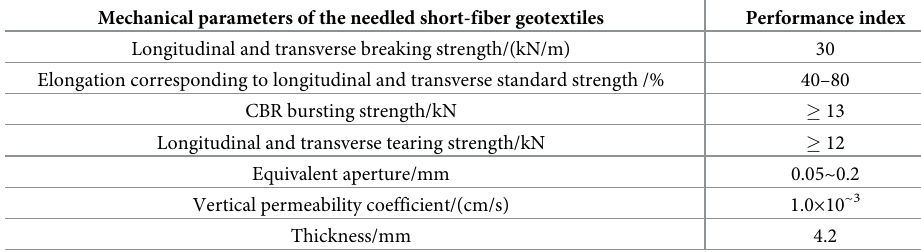
Table 2. Performance parameters of the